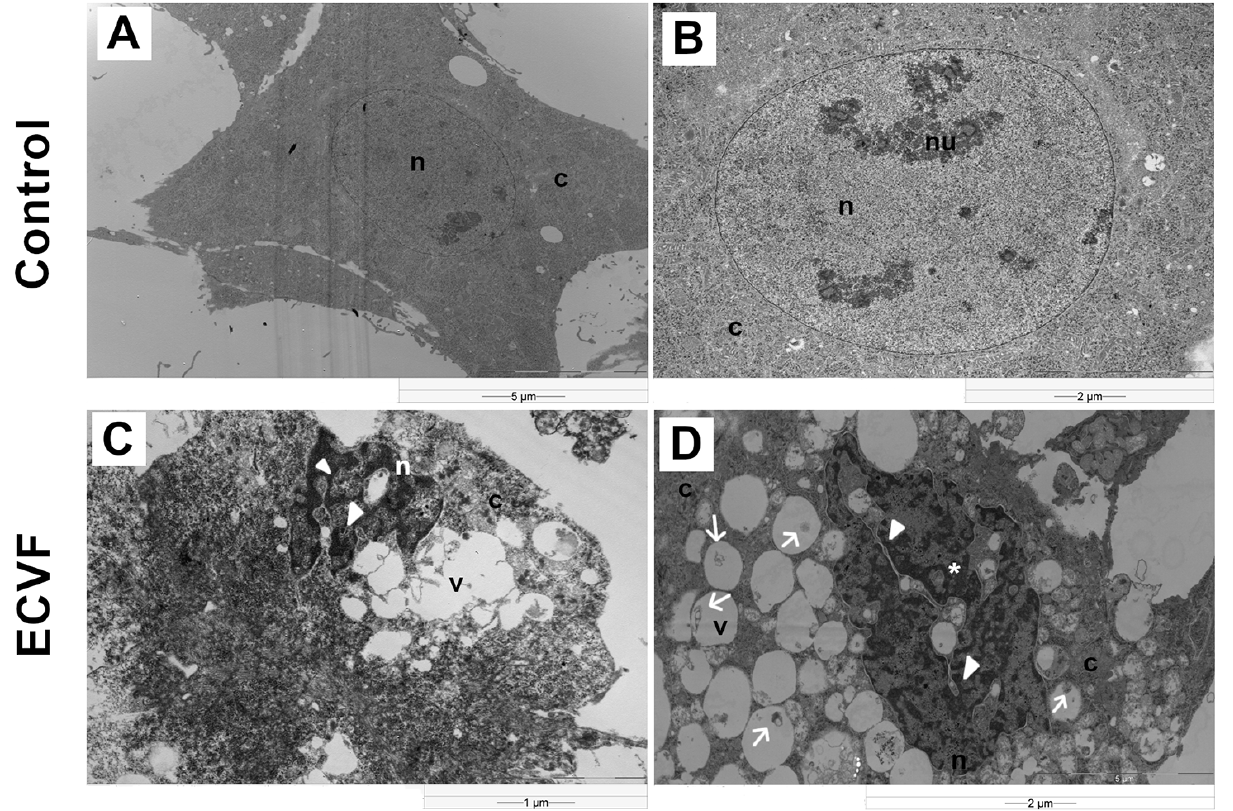
Figure 3. Intracellular alterations in CEC-32 fibroblasts induced by ECVF treatment. (A, B) Control, untreated fibroblasts, after 24 hours. Electron micrographs of untreated cells show endomembrane system distributed in a less compact cytoplasm and a round-shaped nucleus with orderly euchromatin, typical of nucleus at the interphase. (C, D) Electron micrographs of treated cells show endomembrane system with numerous vacuoles of irregularly shapes, filled with membranous components. Vacuoles also show signs of swelling and are distributed in compacted cytoplasm. Nuclei exhibit irregular shape and display an abundance of lobulations and also a high content of heterochromatin associated to nuclear envelope. n: nucleus; nu: nucleolus; c: cytoplasm; v: vacuoles. *Asterisks indicate chromatin condensation, arrowheads indicate nuclear lobulation and arrows indicate intravacuolar structures. Scale bars = 5 μm (A) , 2 μm (B, D) , 1 μm (C)